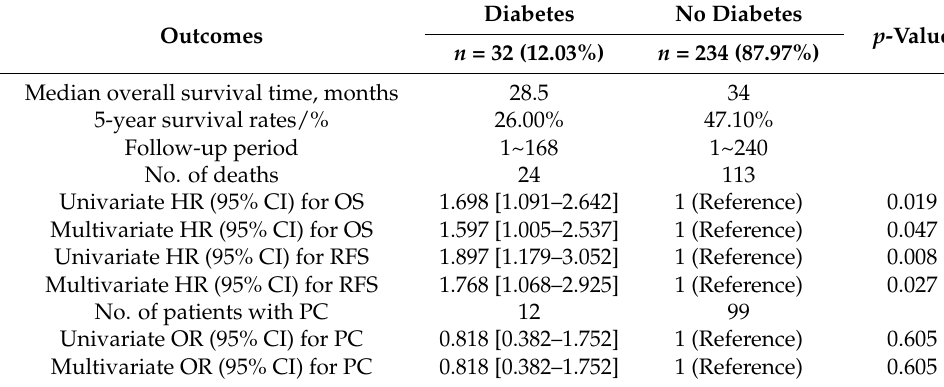
Table 4. Univariate and multivariate analysis of short-term and long-term outcomes between the diabetes group and the no diabetes